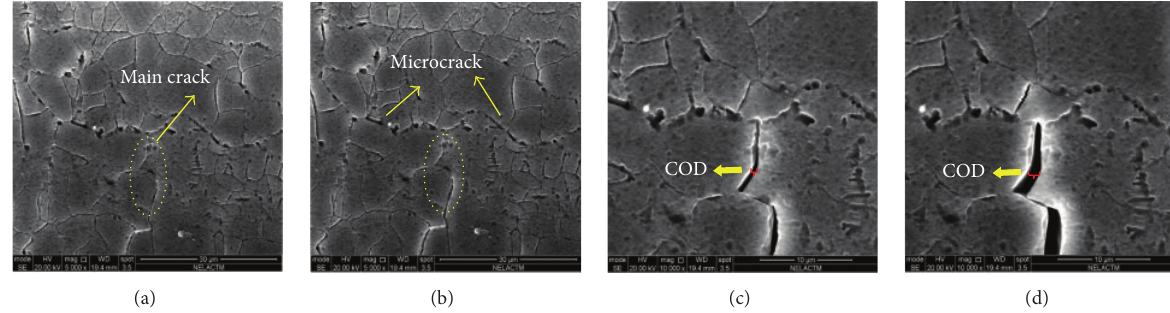
Figure 5: In the loading stage of 99 cycles, micromorphology of fatigue crack at different loading level: (a) at 540 N, (b) at 960N, (c) at 1380 N, and (d) at 1750N.